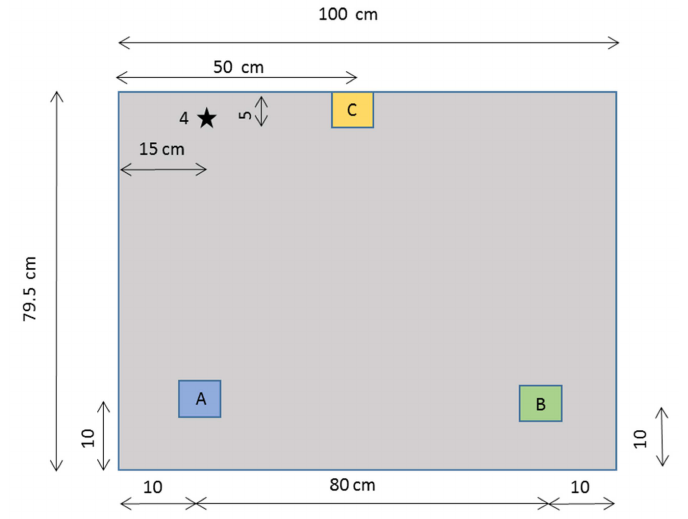
Figure 13. Scheme for Case Study